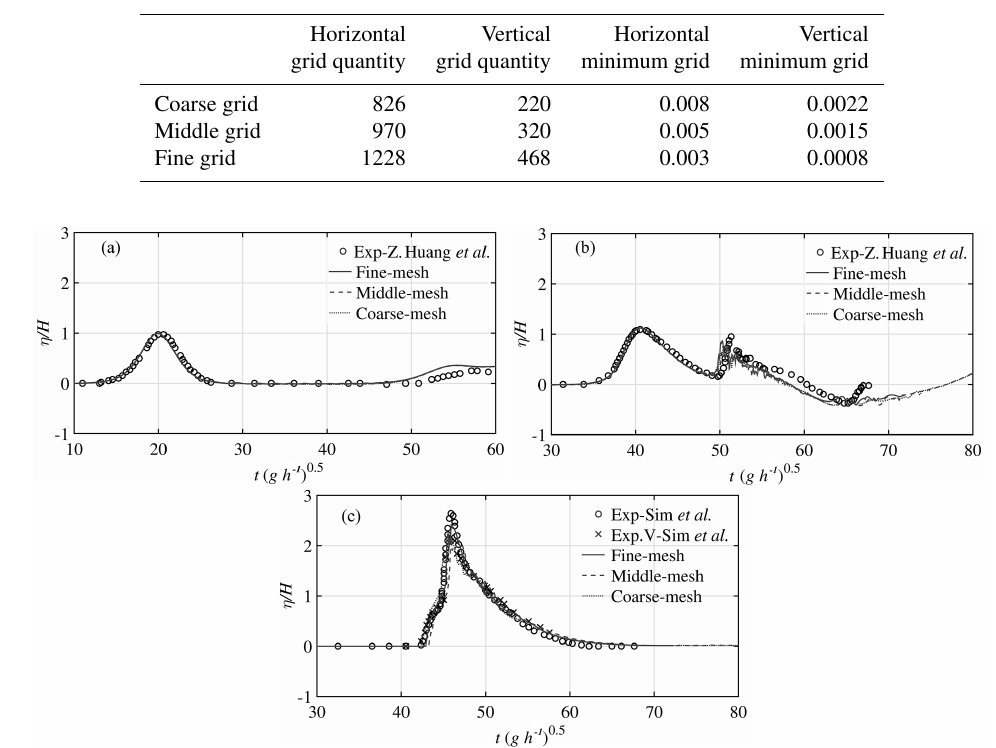
Figure 5. Time series of experimental data and predicted water elevations using different grids: (a) S1, (b) S2 and (c) S3.